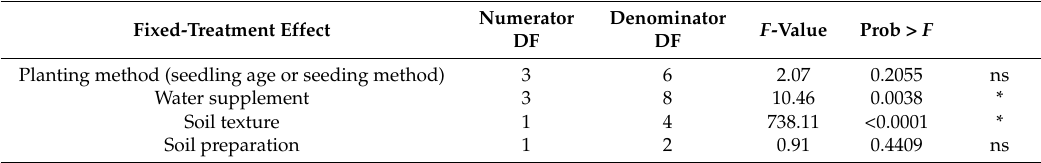
Figure 7. Cost of each of 42 planting treatment combinations. Plantings at Arz-Bcharre (Bcharre in figure) were Lebanon cedar; all others were stone pine. Treatment attributes (on y -axis) included those for planting material (8-, 10-, 12-, and 18-month-old seedlings; SS200 = 200 seeds sown in patch; SP3 = 3 seeds planted at points), water supplement (NRSW = non-rechargeable solid water, RSW = rechargeable solid water, IRR = conventional hose irrigation, NIRR = no irrigation), soil texture (Sd = sandy, SC = silt-clay), and soil preparation (MP = mechanical preparation, HP = hand tool preparation, NP = no preparation). Table 2. Linear mixed-models statistical tests for 4 fixed-treatment effects (while adjusting for 6 “repeated” or random-like site effects) showing significance or